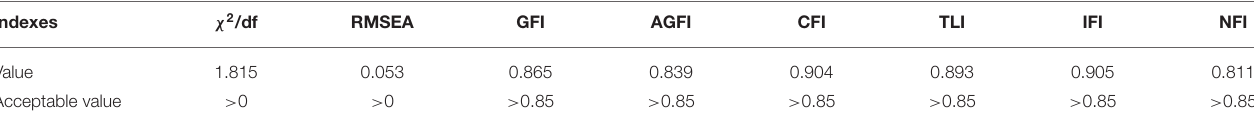
TABLE 4 | Goodness-of-fit statistic of the